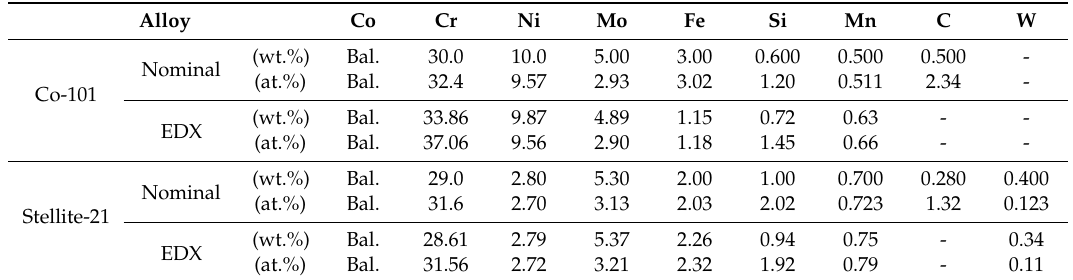
Table 1. Nominal and actual (determined by EDX) compositions of alloys Co-101 and Stellite-21.